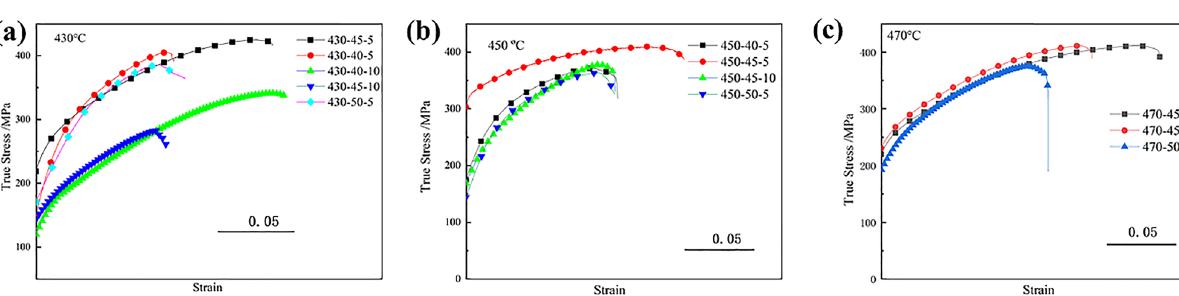
Figure 9. True stress–strain curves of sintered Mg–15Gd–1Zn alloys: ( a) at 430 °C; ( b) at 450 °C; ( c) at 470